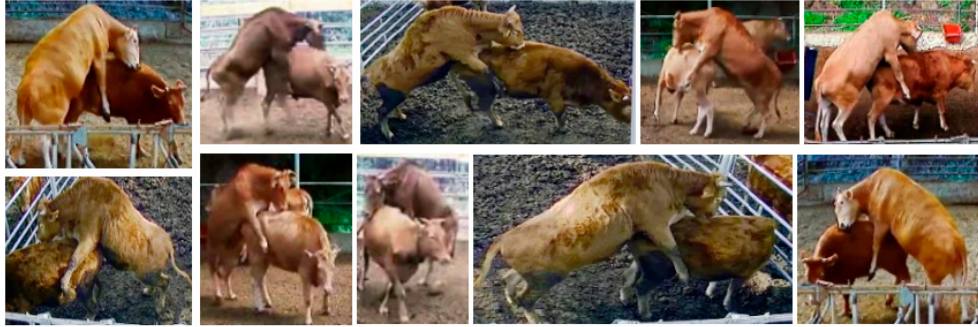
Figure 7. Images for training mounting activities .